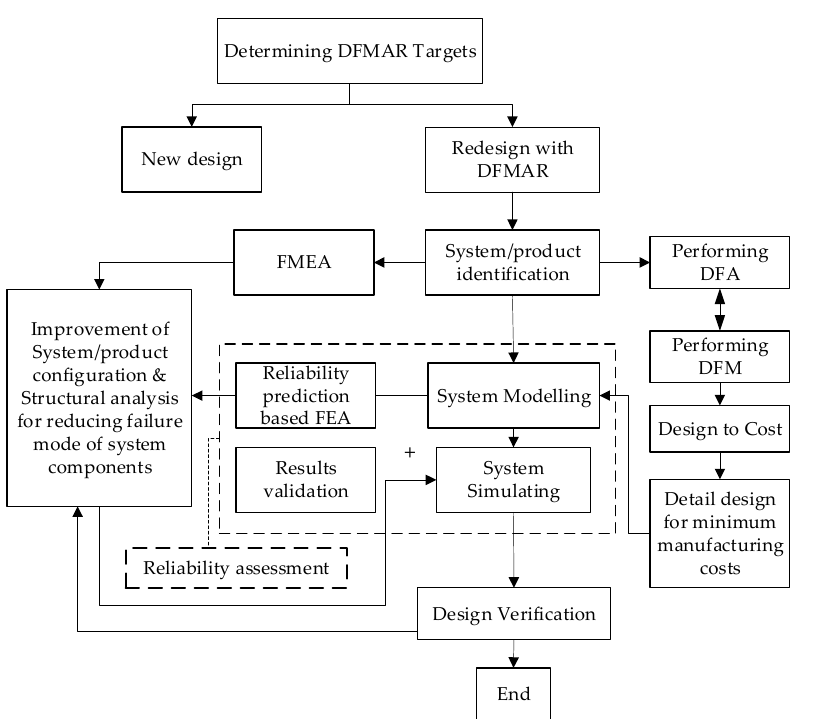
Figure 4. An integrated framework of DFMAR (proposed model).